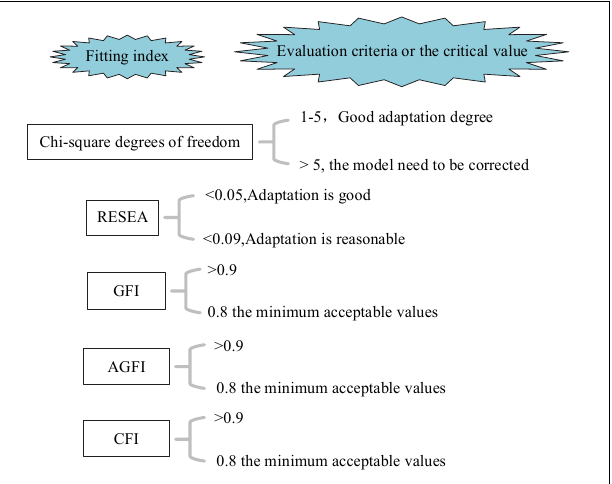
FIGURE 9 | Evaluation criteria of model fitting degree.